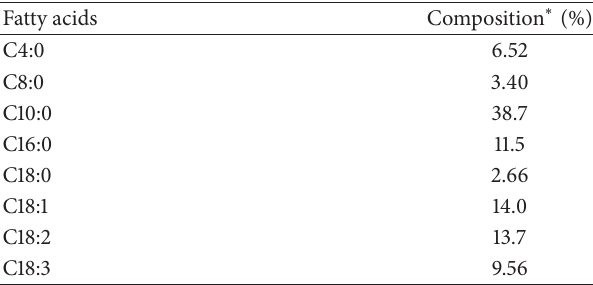
Table 2: Fatty acid profile of the Spirulina platensis microalga oil. Fatty